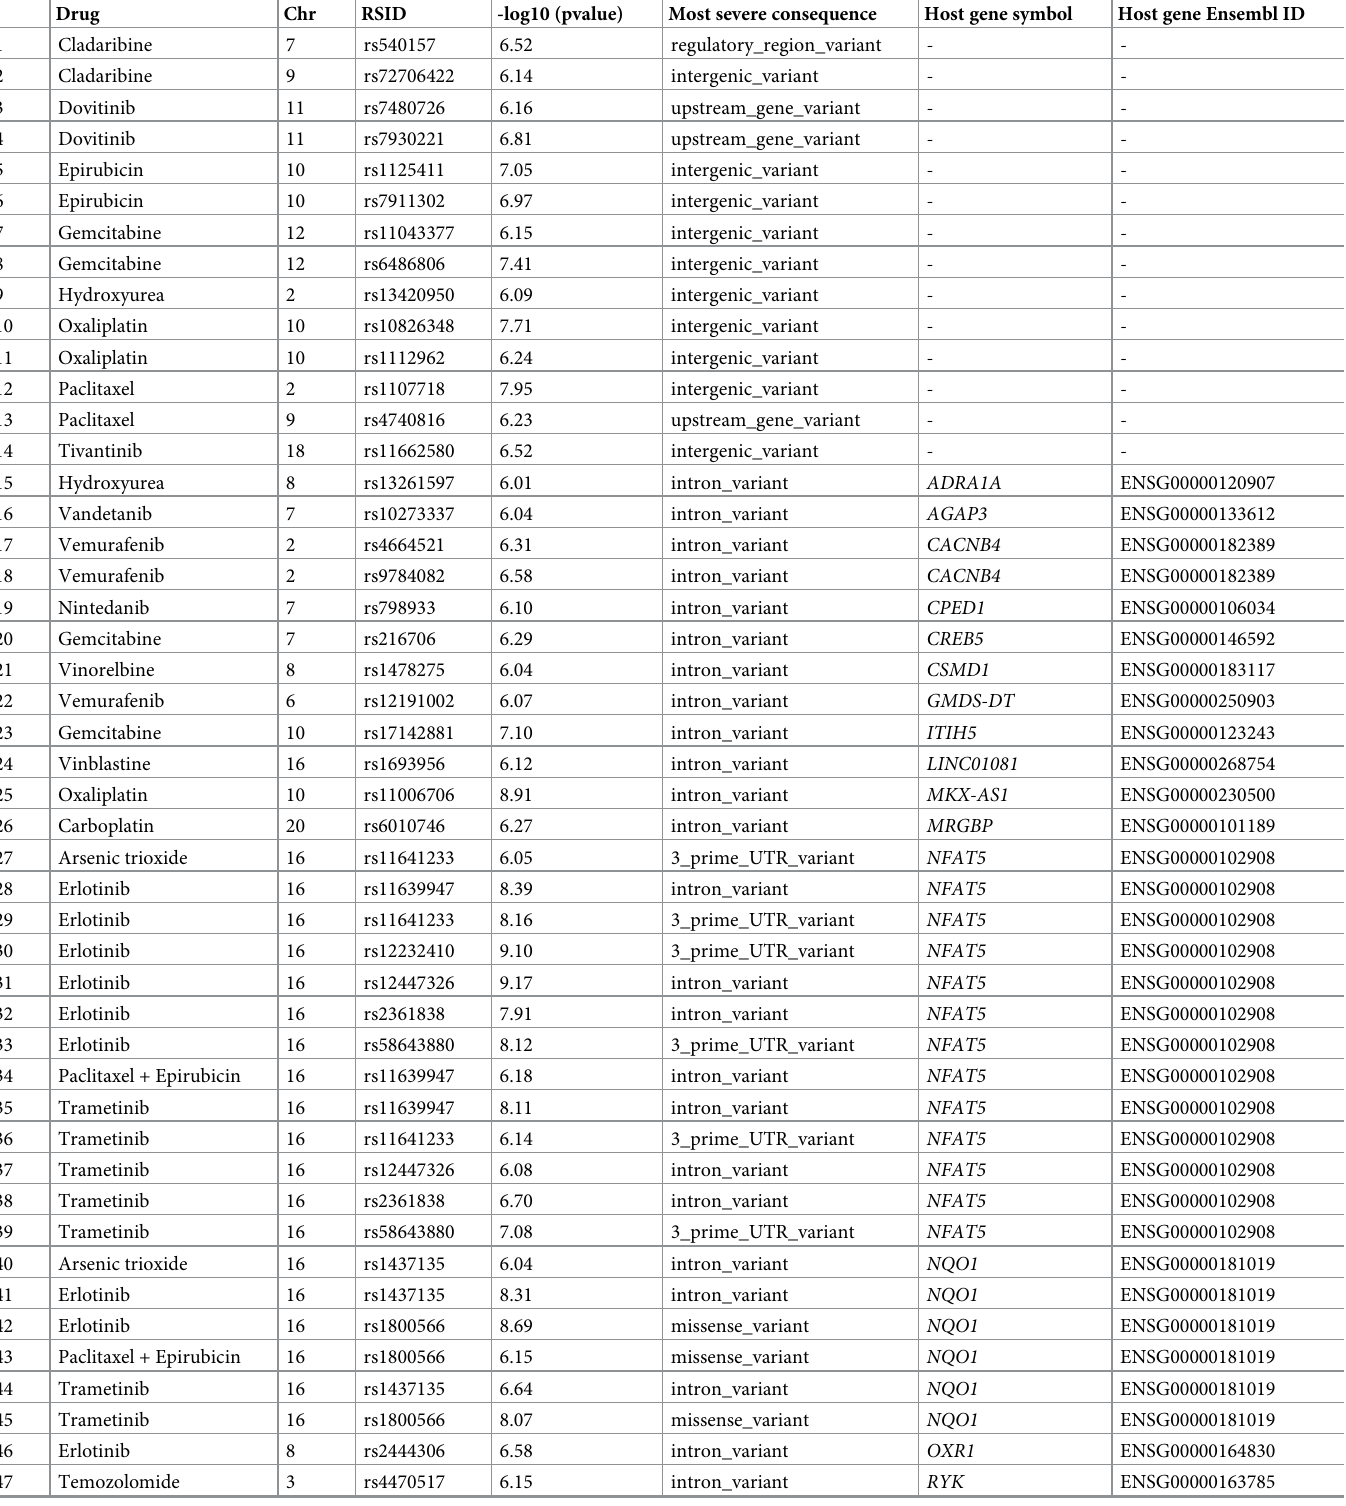
Table 2. SNPs significantly associated with drug